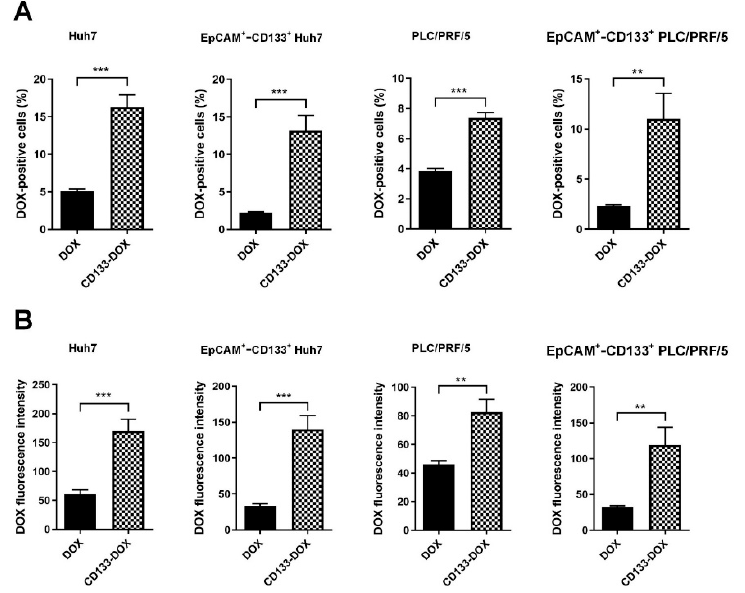
Figure 3. DOX accumulation in the bulk and EpCAM + -CD133 + population of the liver cancer Huh7 cells and PLC/PRF/5 cells. After incubation with free DOX or CD133 aptamer-DOX conjugates (200 nM for Huh7 and 100 nM for PLC/PRF/5) for 24 h, the intracellular accumulation of DOX was analyzed via flow cytometry. ( A ) The percentage of DOX-positive cells, and ( B ) the corresponding median intracellular DOX fluorescence intensity. Data shown are means ± SD, n = 3. ** p < 0.01; *** p < 0.001, compared to free DOX treatment.